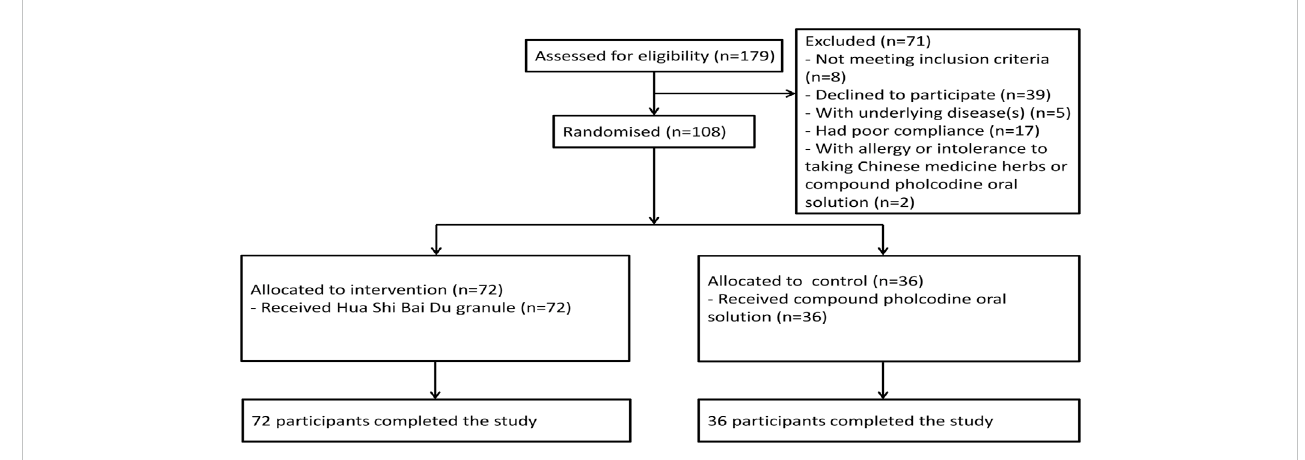
FIGURE 1 Flow diagram showing the progress of participants through the trial.